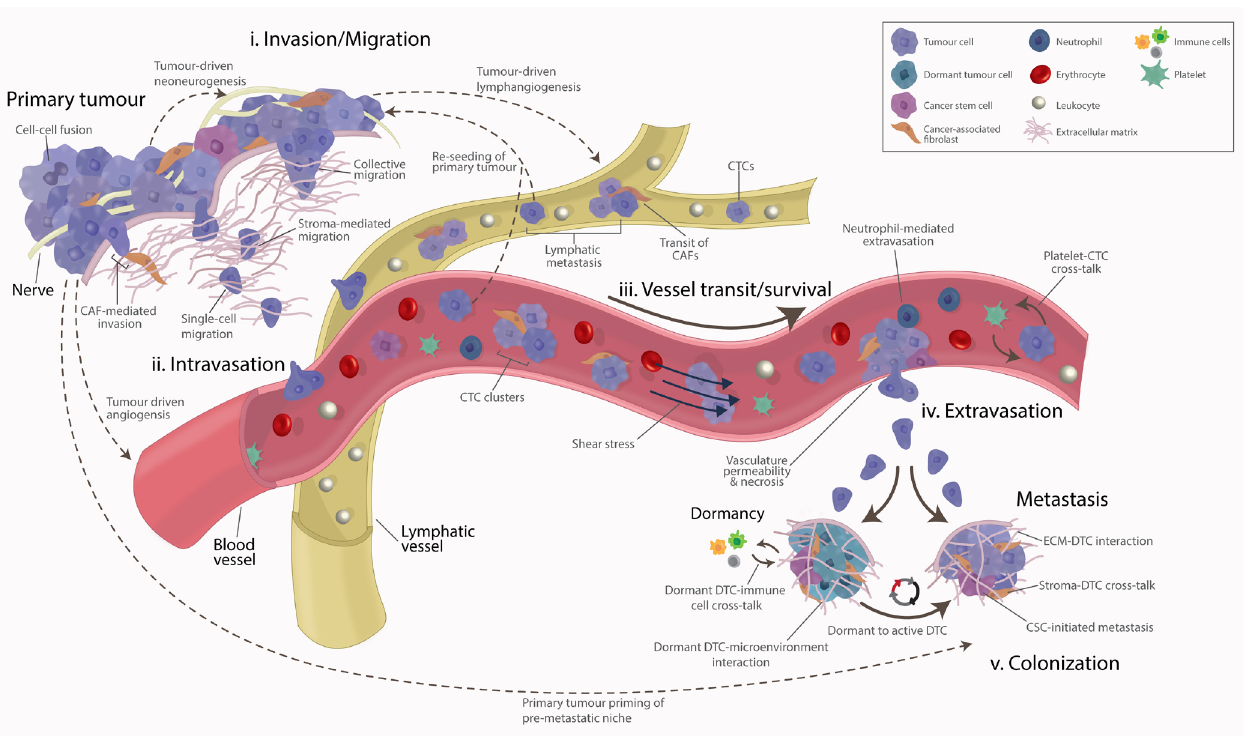
Figure 1. Tumour metastasis is a vast and interconnected array of dynamic and systemic events encompassing both spatial and temporal events. The process can be broadly divided into the following stages: ( i ) invasion/migration at/near the primary tumour, ( ii ) intravasation into the local blood and lymphatic vessels, ( iii ) survival and transit of cancer cells in the circulation/lymphatics, ( iv ) arrest and extravasation at secondary sites, and ( v ) overt colonisation of secondary